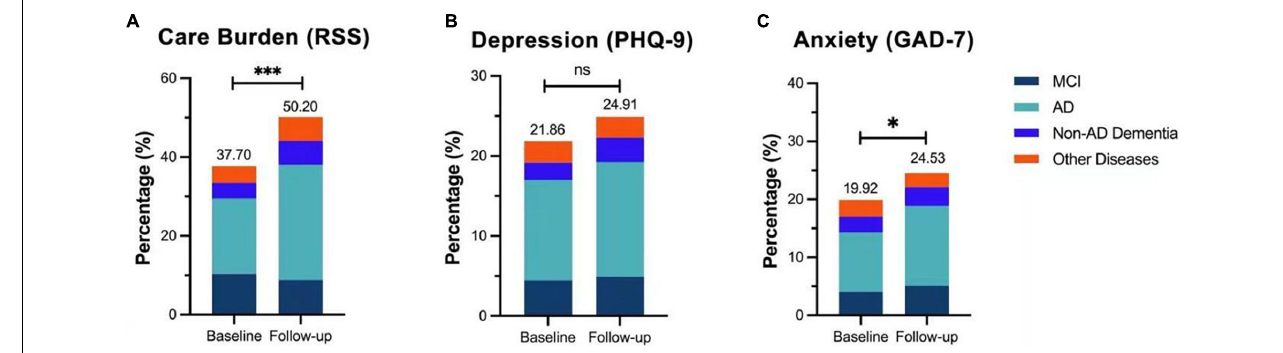
FIGURE 3 | Care burden and mental status of caregivers. Notably, 50.20% of caregivers suffered from different degrees of care burden in follow-up with a nearly 13% increase from the baseline ( χ 2 = 10.293, *** P < 0.001) (A) . After the quarantine, the prevalence of depression among caregivers was elevated by 3.05% ( χ 2 = 1.357, P = 0.137) (B) , and anxiety increased by 4.61% ( χ 2 = 3.209, * P < 0.05) (C)